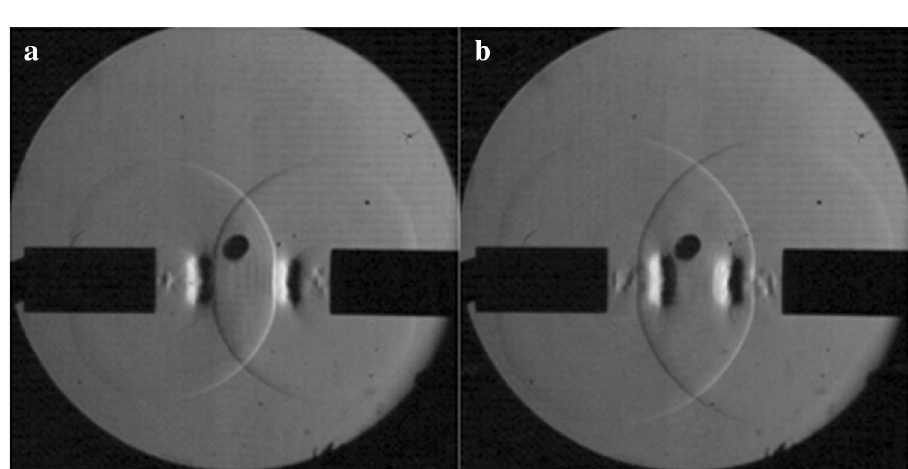
Figure 3. ( a ) Shock wave deformation before vortex collision ( b ) Shock wave leading edge catching up with the rest of the shock